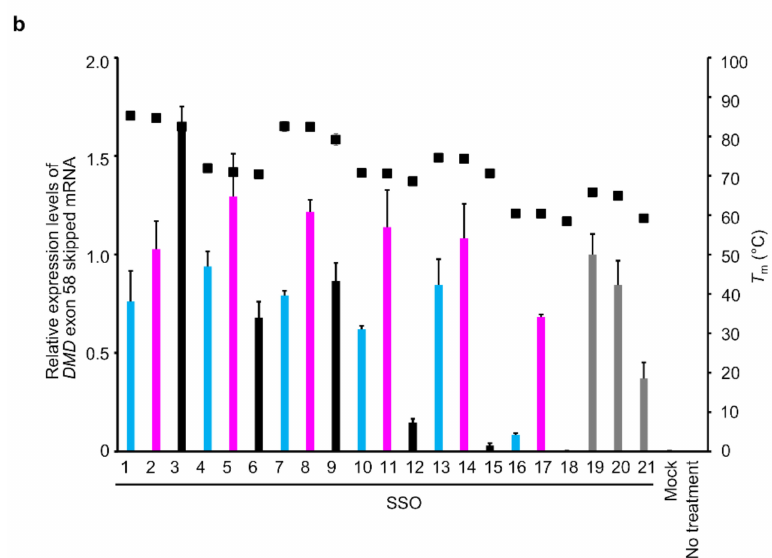
Figure 2. Design and evaluation of 13- to 18-mer LNA/AmNA/GuNA/2 (cid:48) -OMe RNA-modified splice-switching oligonucleotides (SSOs) targeting DMD exon 58 and having different lengths and modification content. ( a ) Schematic representation of 13- to 18-mer LNA, AmNA, GuNA, and 2 (cid:48) -OMe RNA-modified SSOs targeting DMD exon 58 designed for the assay. ( b ) Evaluation of 13- to 18-mer BNA-modified SSOs targeting DMD exon 58 and having different lengths and modification content using the stably transfected cells, stable-e58. Results of RT-qPCR analysis. The stable-e58 cells were transfected with the indicated SSOs (10 nM) for 24 h. On the X -axis of the graph, transfected SSOs are shown with SSO numbers mentioned in ( a ). The expression of exon 58 skipped mRNA was measured by RT-qPCR (bar). The expression was normalized to the RPLP2 mRNA signal, relative to the value of 18/18_2 (cid:48) -OMe_e58-1 (SSO19) set to 1. Values represent the mean ± standard deviation of three independent experiments performed in duplicate. The melting temperature ( T m ) value of SSOs was measured from 5 to 94.5 ◦ C (black box). Mock: treated with Lipofectamine only; no treatment: no transfection. Values represent the mean ± standard deviation of three independent